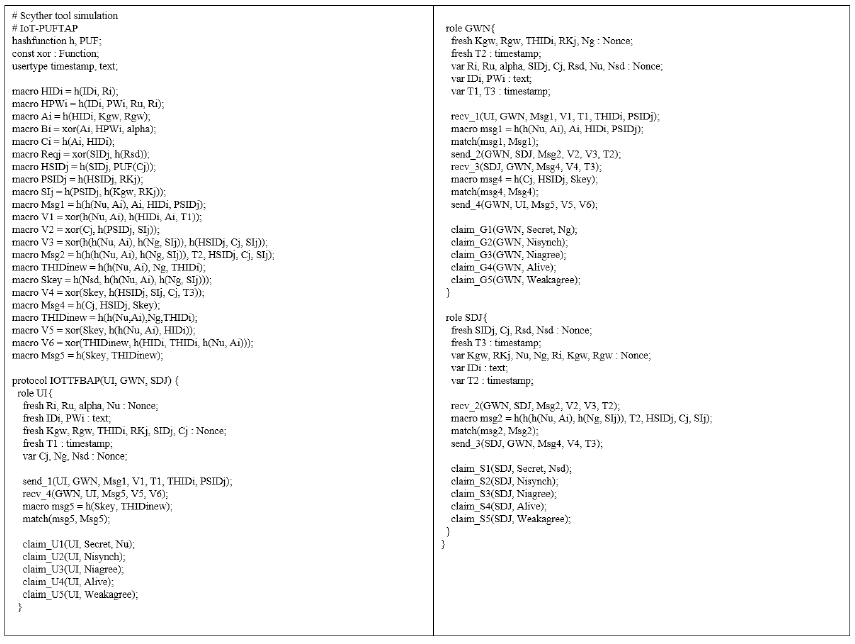
Figure 5. PUFTAP-IoT written in SPDL code.